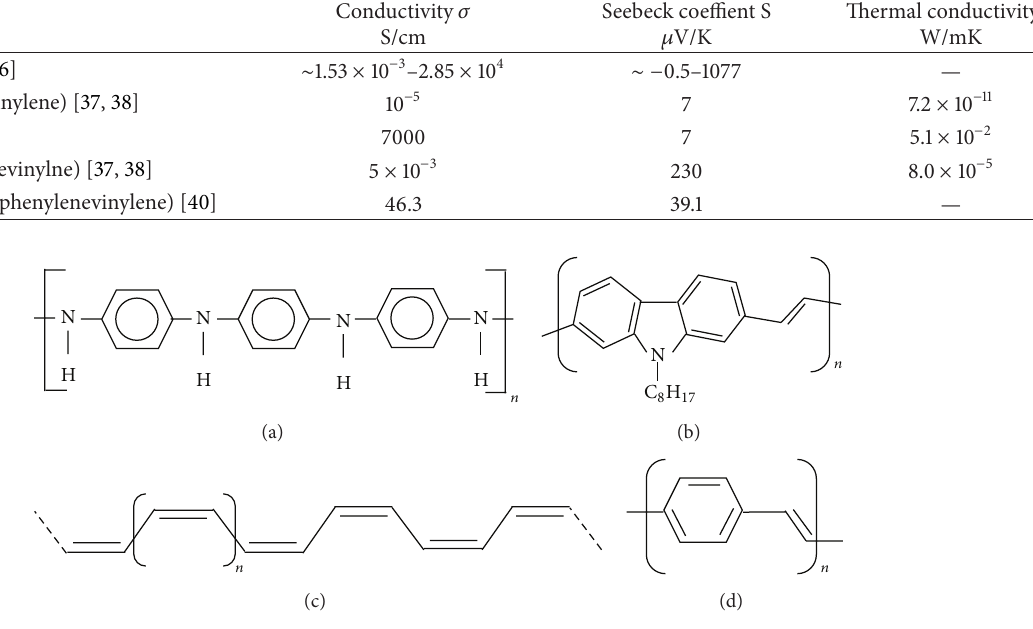
Figure 1: Various polymer structures of (a) polyaniline, (b) poly(2,7-carbazolenevinylene) [47], (c) polyacetylene and (d) poly( p -phenylene vinylene).